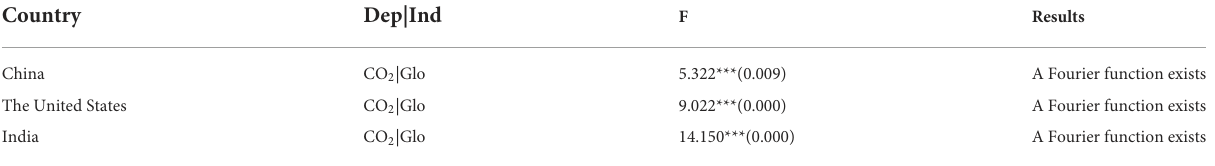
TABLE 3 The existence of a Fourier function—China, the United States, and India.